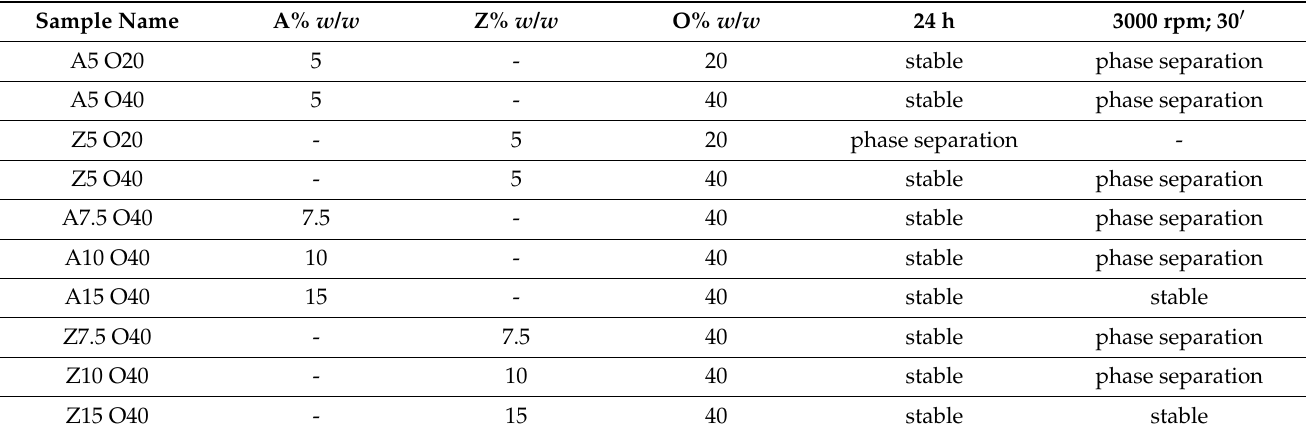
Table 1. Stability test results of systems emulsified with Zea mays starch (A) and zinc oxide (Z) used alone at different concentrations, varying the percentages of oily phase